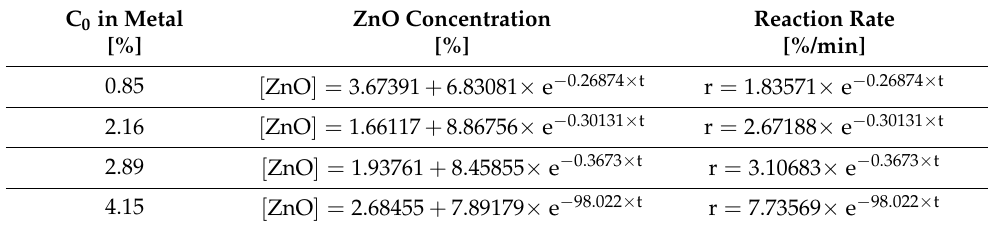
Table 4. Calculated changes in the concentration of zinc oxide in the slag, and the reaction rates.